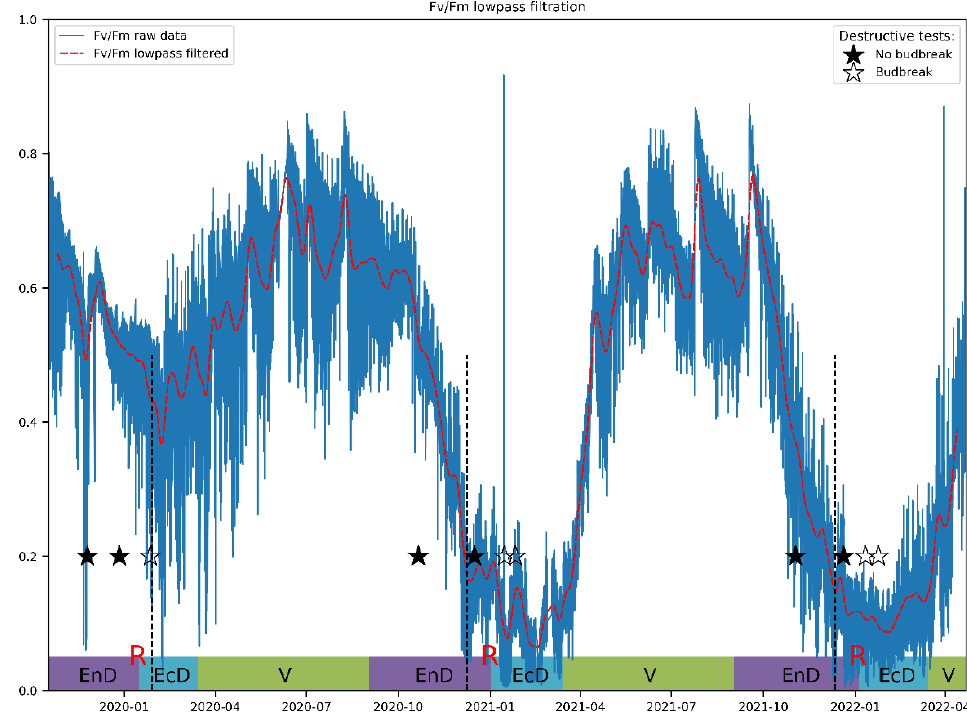
Figure 4. A typical view of an actual Fv/Fm record and its general trend obtained by the lowpass filtering of the respective time series. The annotations at the bottom denote approximate duration of dormancy and vegetation phases (V, vegetation period; EnD, endodormancy; EcD, ecodormancy; R, endodormancy release; destructive tests: (cid:70) , no budbreak displayed by the cut shoots; (cid:80) , budbreak in room conditions). Vertical dashed lines denote the date of endodormancy release according to our model.